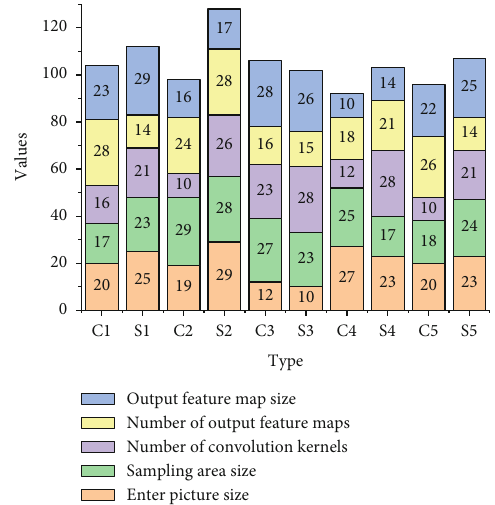
Figure 3: Network convolutional and downsampling layer